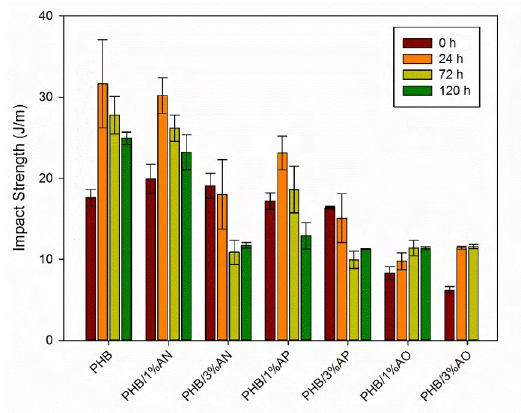
Figure 8. Effect of thermal aging at 115ºC for indicated times on the impact strength of PHB and PHB compounds with natural, purified and, purified/organophilized